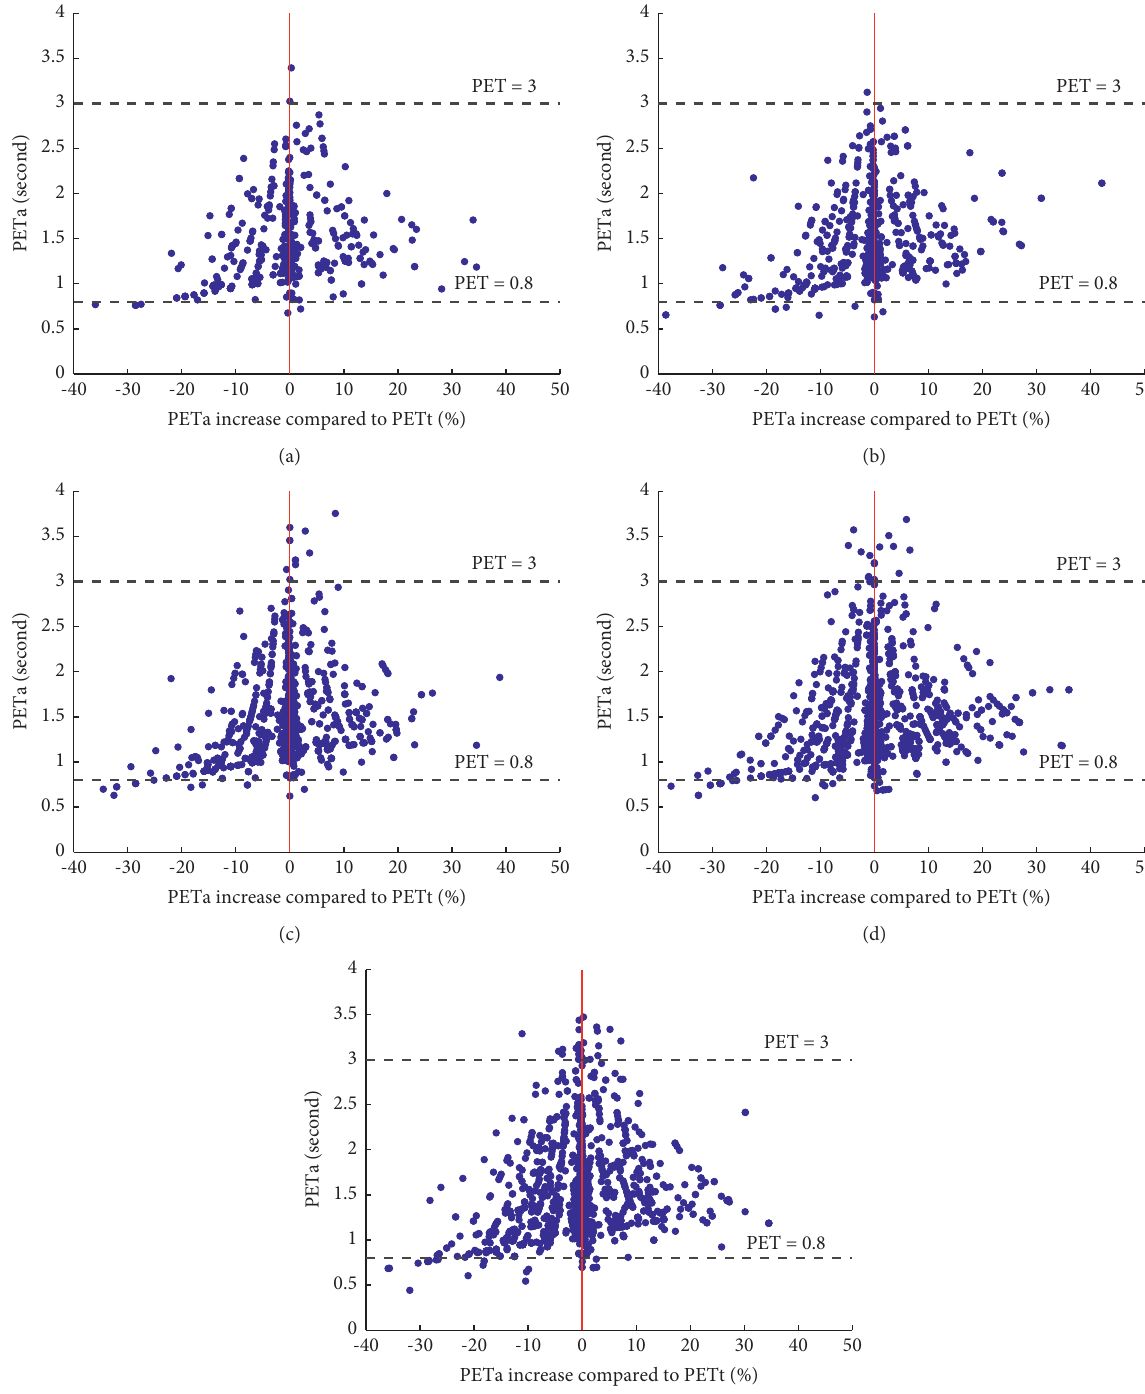
Figure 7: Relationships between PET a and PET a increase compared to PET t . (a) 500veh/h/lane. (b) 600veh/h/lane. (c) 700veh/h/lane. (d) 800veh/h/lane. (e)